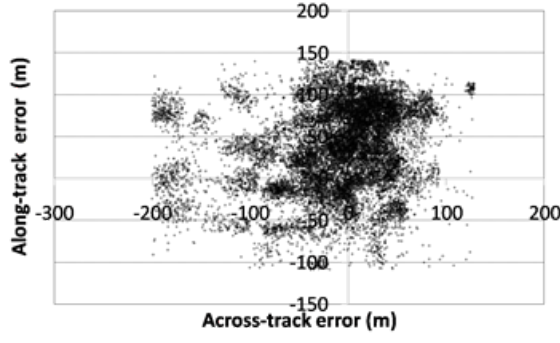
Figure 7 Absolute location performance of AWF after